Question: Express in one sentence what the figure is showing.
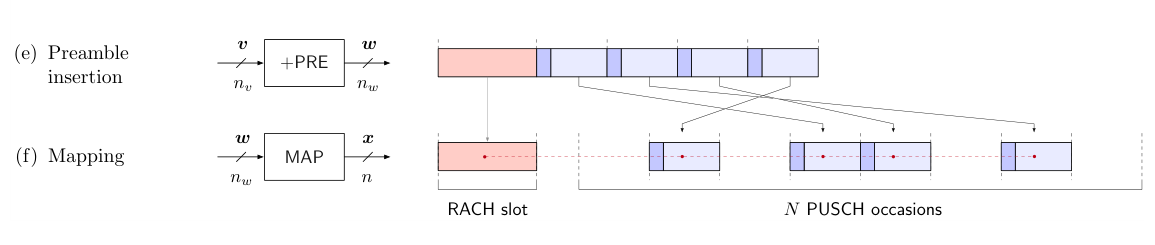
Answer: Detailed description of the transmission steps of Figure 5.